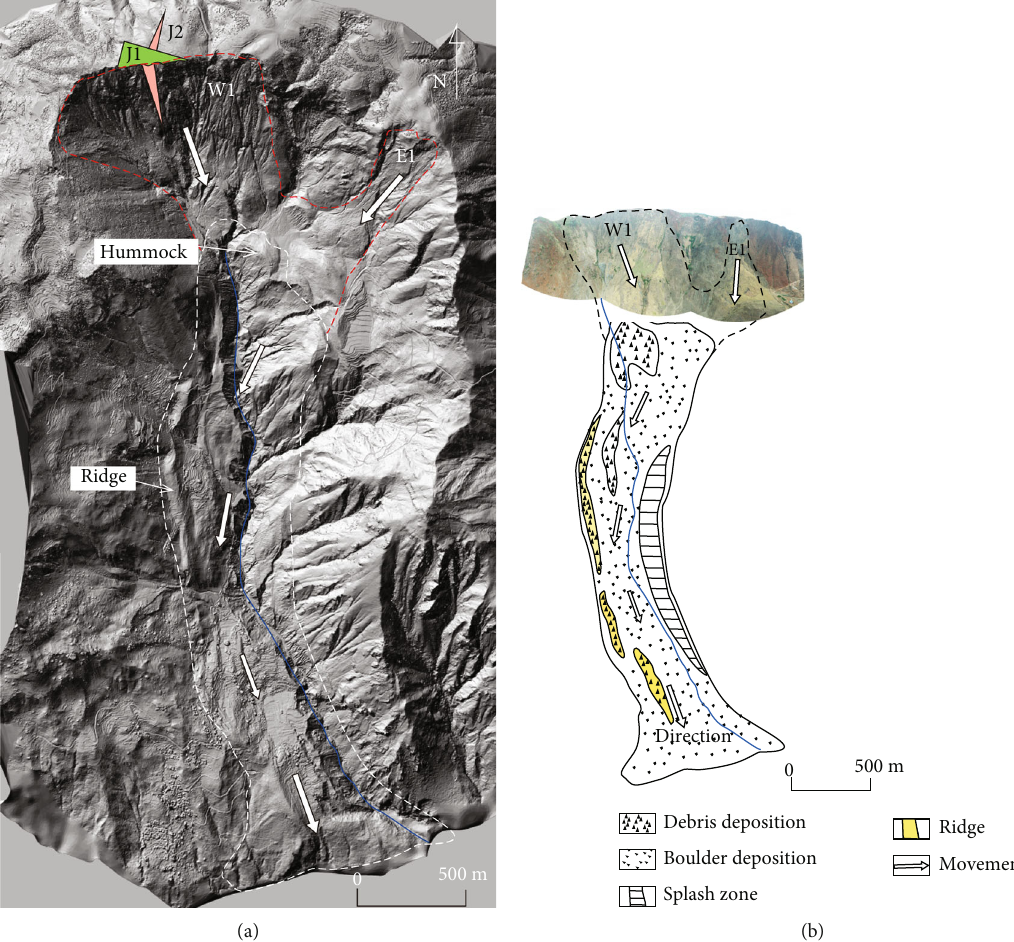
Figure 4: (a) Structural analysis of DEM mountain image in the source area and (b) the zoning map of sedimentary